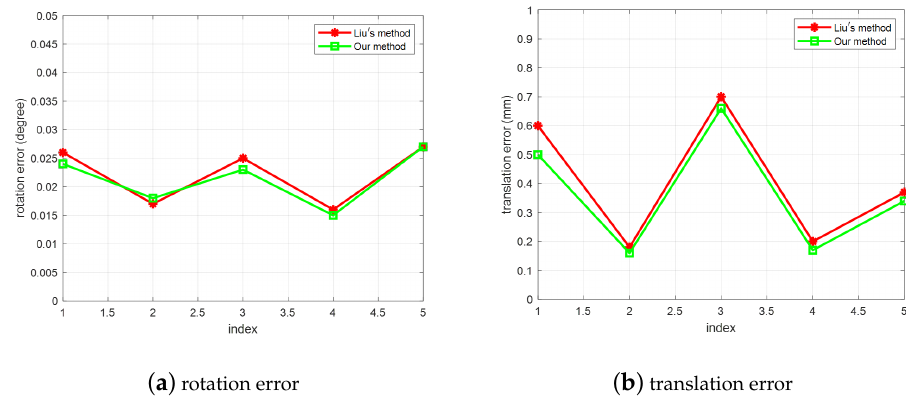
Figure 8. The comprehensive rotation and position errors of two methods: ( a ) rotation error; ( b ) translation